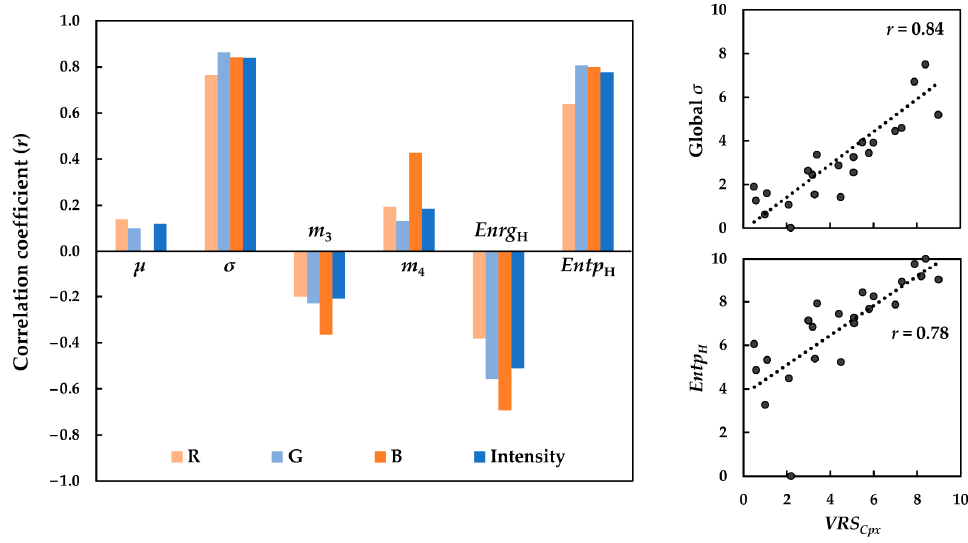
Figure 10. The correlation between the VRS Cpx of the textiles and various image descriptors computed for the R, G, and B channels and the sRGB intensity images of the textiles ( left ). Scatter plots of the global σ and Entp H versus the corresponding VRS Cpx for the sRGB intensity images ( right ).